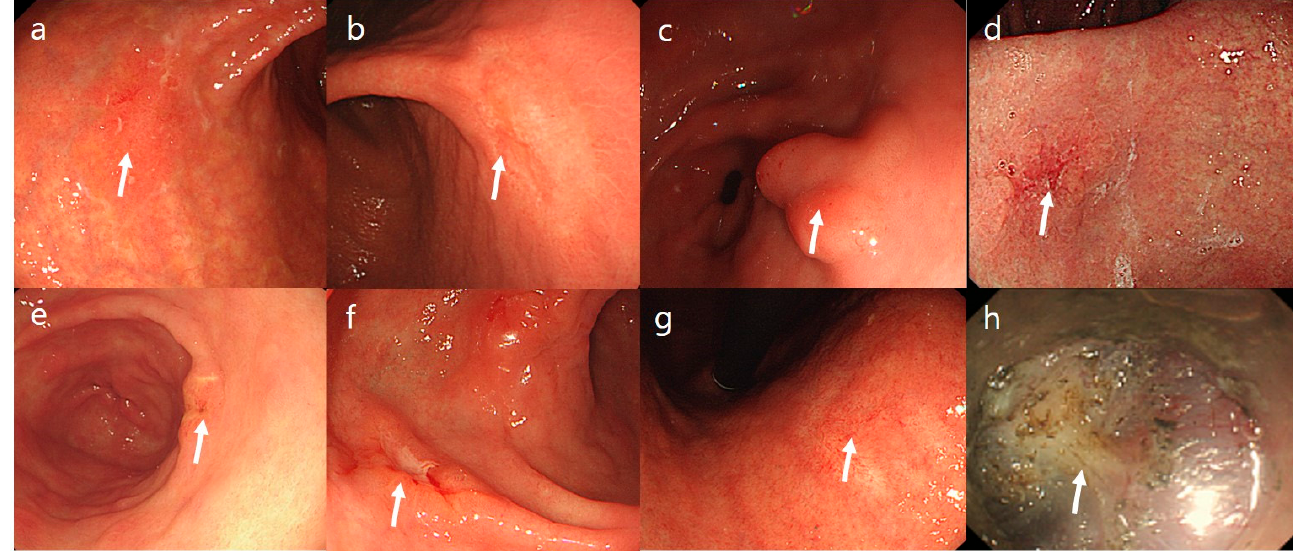
Figure 2. Endoscopic characteristics of early gastric cancer lesions. ( a , b ) Erythematous mucosa. ( c ) Nodular mucosa. ( d ) Depression. ( e ) Erosion. ( f ) Active ulcer. ( g ) Scar. ( h ) Submucosal fibrosis.